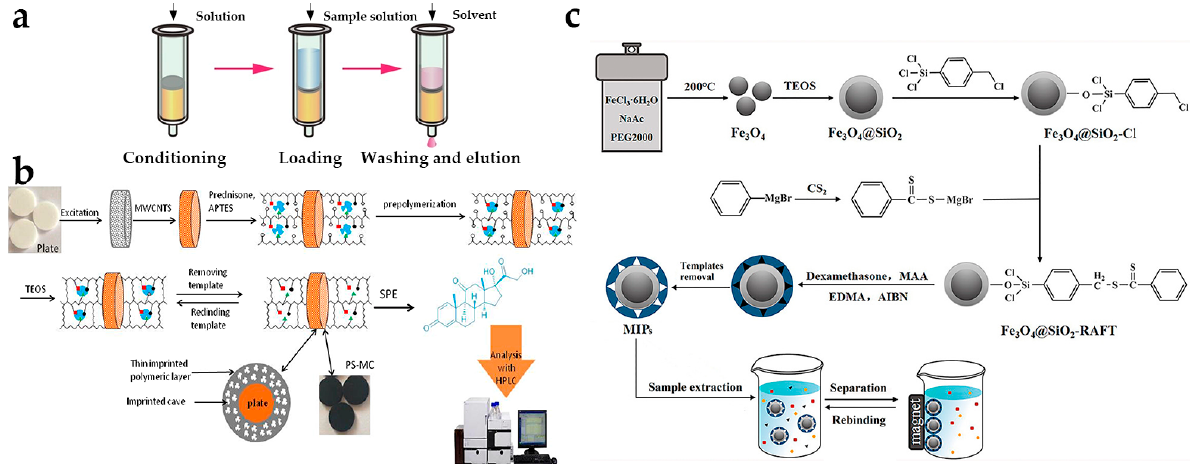
Figure 3. ( a ) Scheme of sorption-based extraction technique for SPE. Reprinted with permission from Ref. [15] Copyright 2017 Journal of Separation Science. ( b ) Synthesis of plate@MWCNTs@MIPs and their application for SPE. Reprinted with permission from Ref. [52] Copyright 2018 Journal of Colloid and Interface Science. ( c ) Synthesis of magnetic MIPs and their application for MSPE. Re- printed with permission from Ref. [59] Copyright 2018 Journal of Separation Science.